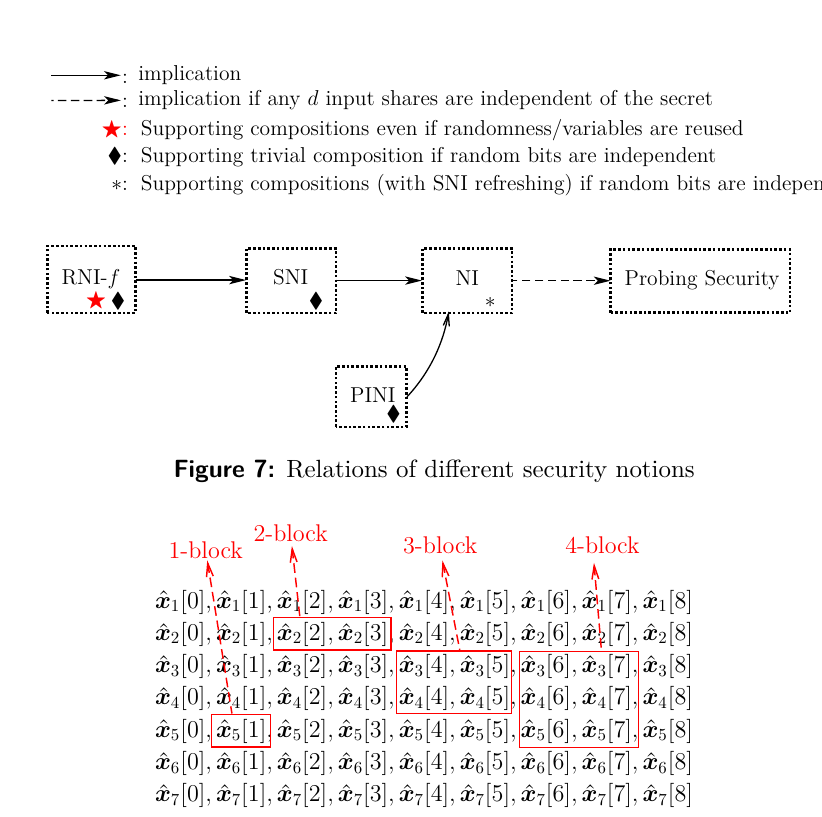
Figure 8: An example to illustrate the blocks in 7 sharings with d = 8. Each row contains shares of a distinct